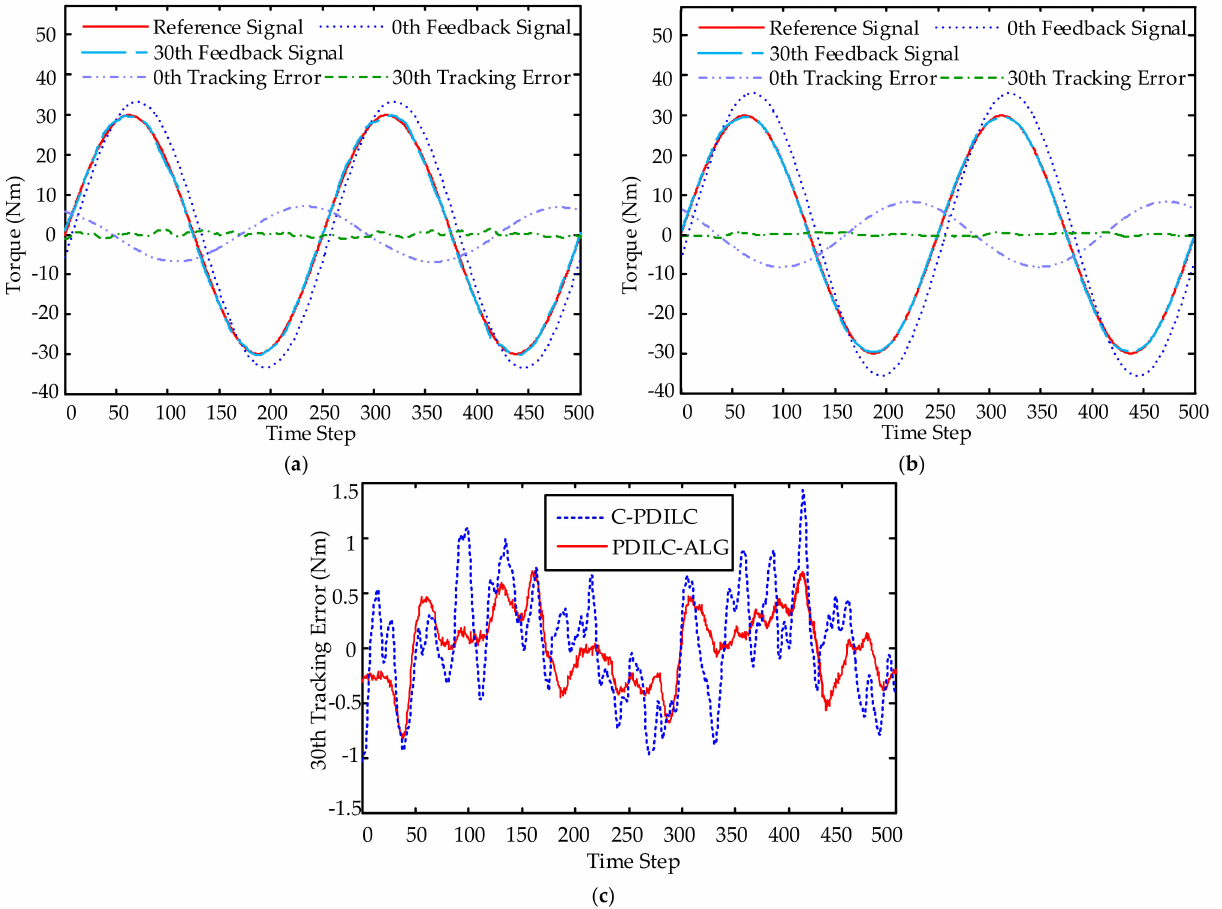
Figure 9. Case 2 experimental results ( θ ∗ a ( t ) = 4 ◦ sin ( 4 π ih ) , y d ( t ) = 30sin ( 4 π ih ) ): ( a ) Loading torque trajectory tracking with the conventional PD-type iterative learning control at the 0th and 30th iterations. ( b ) Loading torque trajectory tracking with the PD-typeiterative learning control with adaptive learning gains at the 0th and 30th iterations. ( c ) The comparison of the loading torque tracking errors at the 30th iteration.